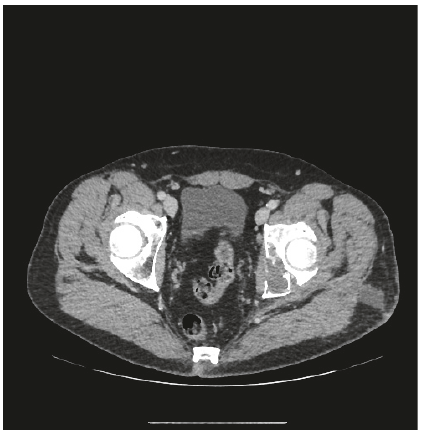
Figure 1: CT-scan: osteolytic lesion on the ischium.